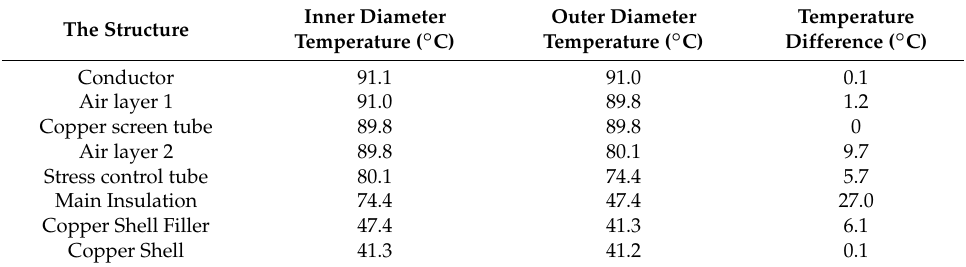
Figure 6. The sampling result of Figure 4. Table 2. Radial temperature differences of each component at the position of the connecting tube in the cable joint.